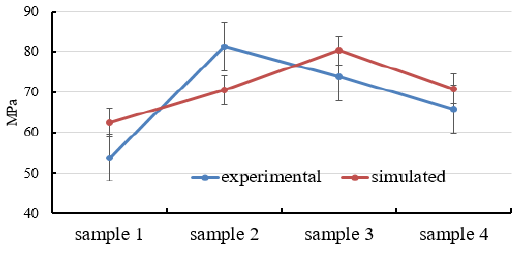
Fig. 3. Experimental results and simulated results of sample residual stress